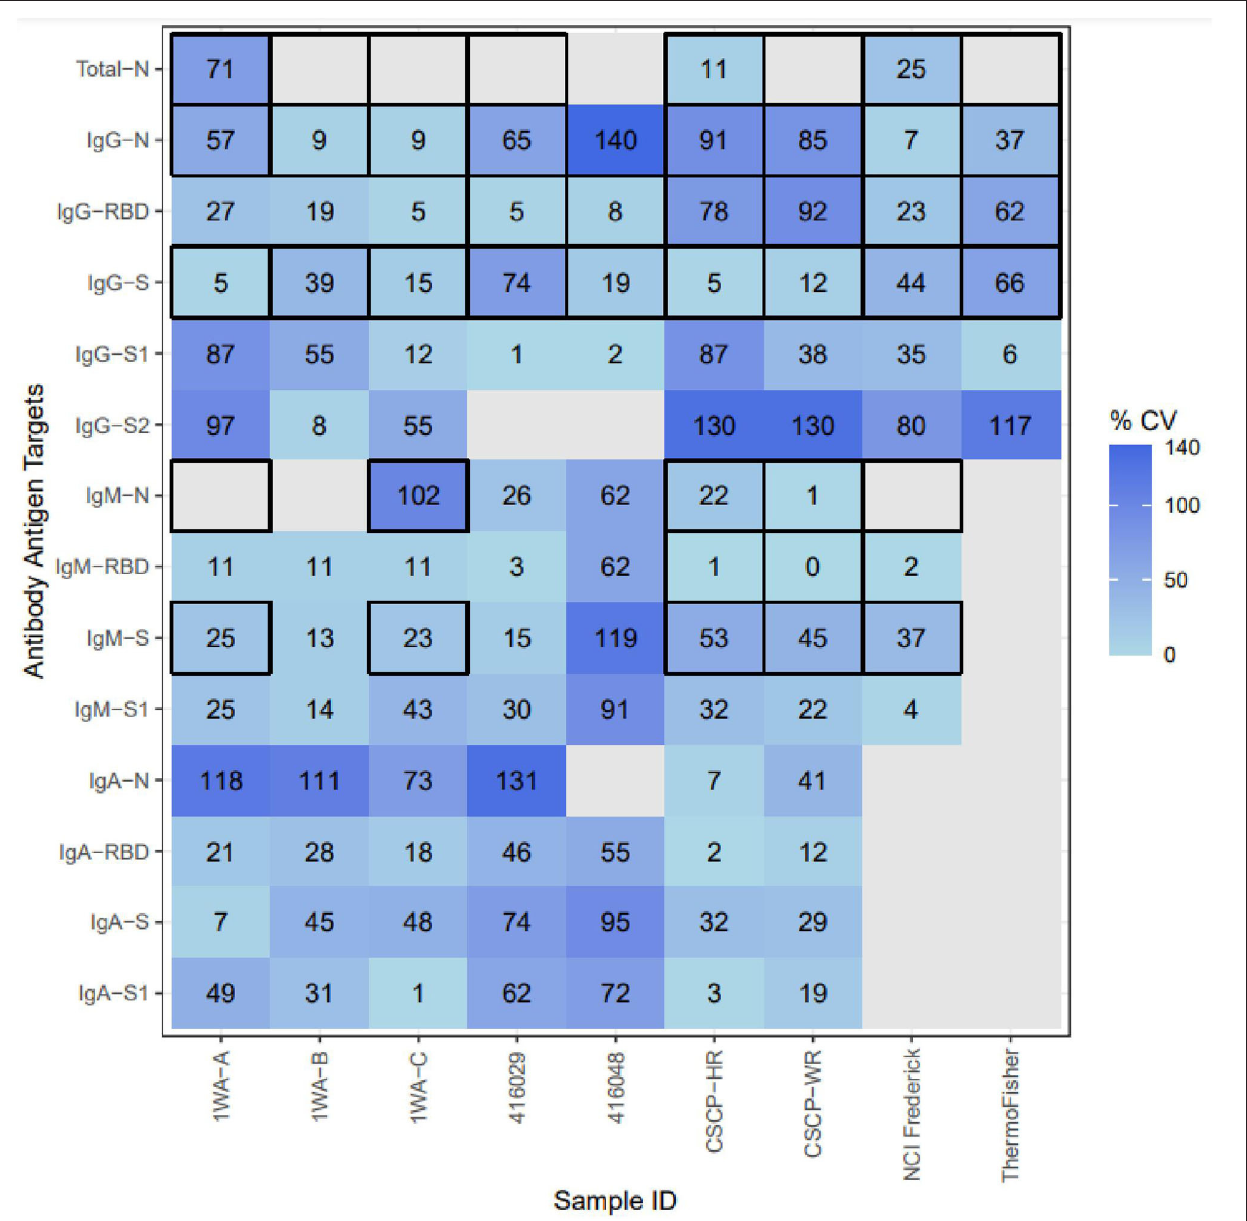
FIGURE 2 | Inter-method concordance of binding antibody unit conversions among reference materials for each analyte. %CV, percent coefficient of variation; Light blue, Higher concordance between methods; dark blue, lower concordance between methods; blank, not enough labs yielded PLA results to compute concordance. Thick Black outlines indicate that the particular analyte was evaluated by that sample’s provider. The following samples were removed because they were classified as “non-reactive” during testing: 1WA-D, 416006, CSCP-NR; The following Ag-Ab combinations were removed due to lack of sufficient PLA data due to linearity violations: Whole-Virus-Total, S2-Total, S2-IgM, S2-Iga, S2-Total, S-Total,